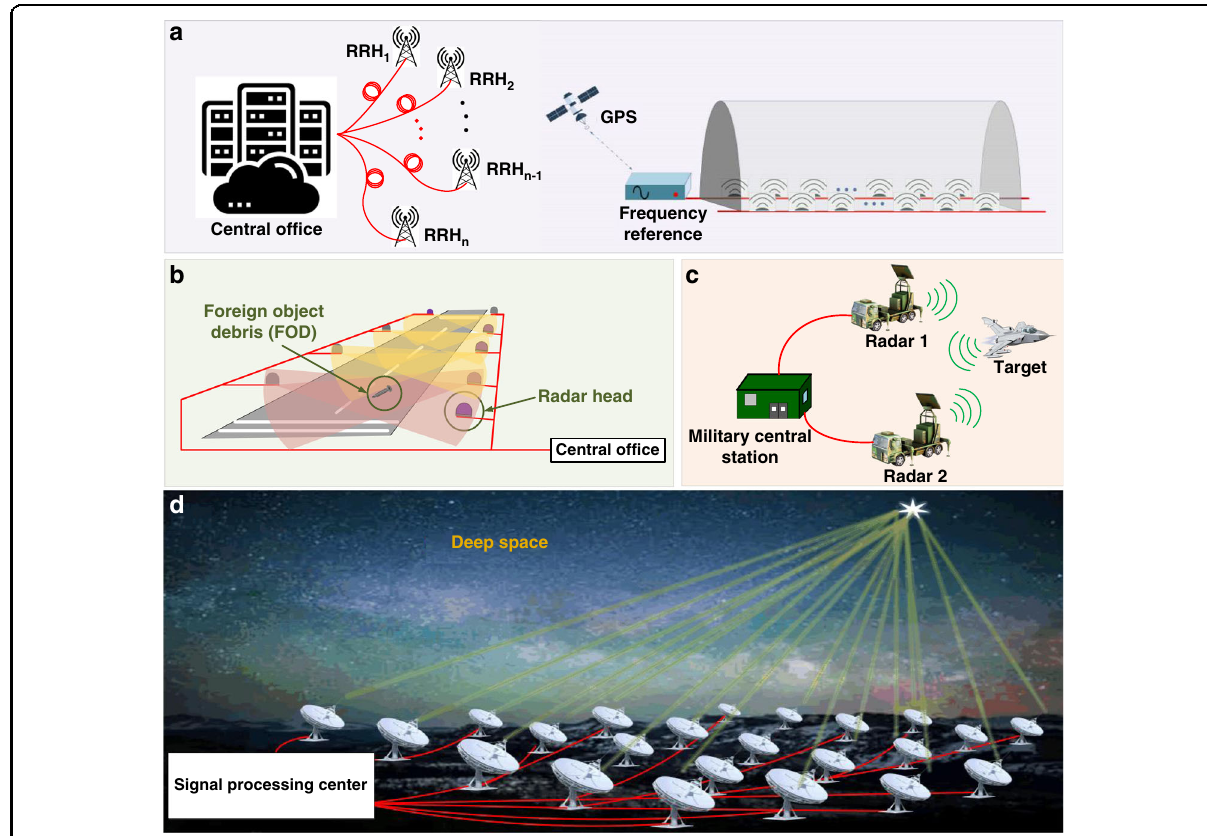
Fig. 1 Examples of applications using long-haul (>1 km) APLs. Fibre links are shown as red lines. a , b Examples of APL use in civil applications, and c , d in military and science applications, respectively. a Connection of a large number of remote radio heads (RRH) for wireless communications providing connectivity, but also timing/positioning (e.g., in a tunnel). b Monitoring and identi fi cation of foreign objects over a large area such as a runway. c Military (high dynamic range) radar systems. d Radio antenna arrays for exploring objects in deep